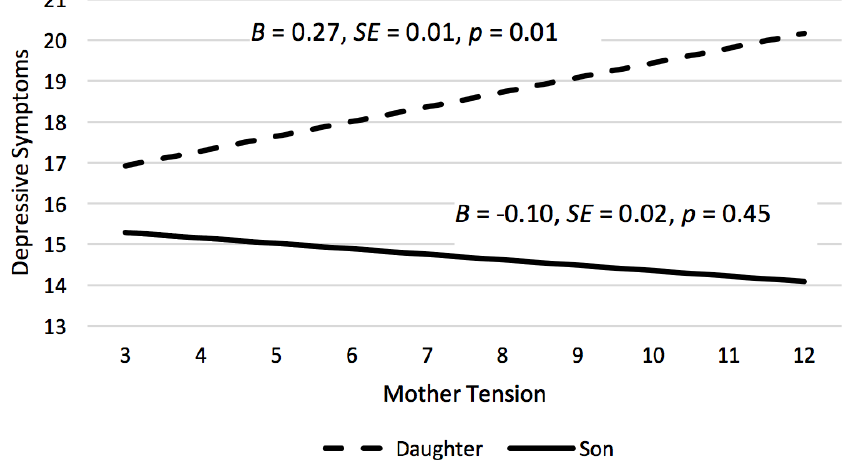
Figure 1. Moderation of Gender on Mother Tension in Association with Depressive